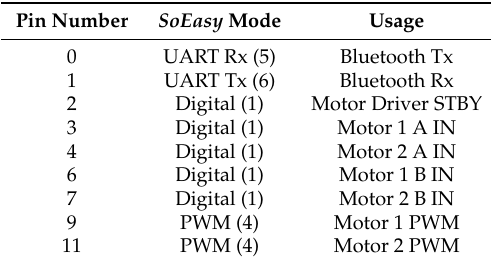
Figure 9. Mobile robot platform. Table 3. Mobile robot control application pin configurations.